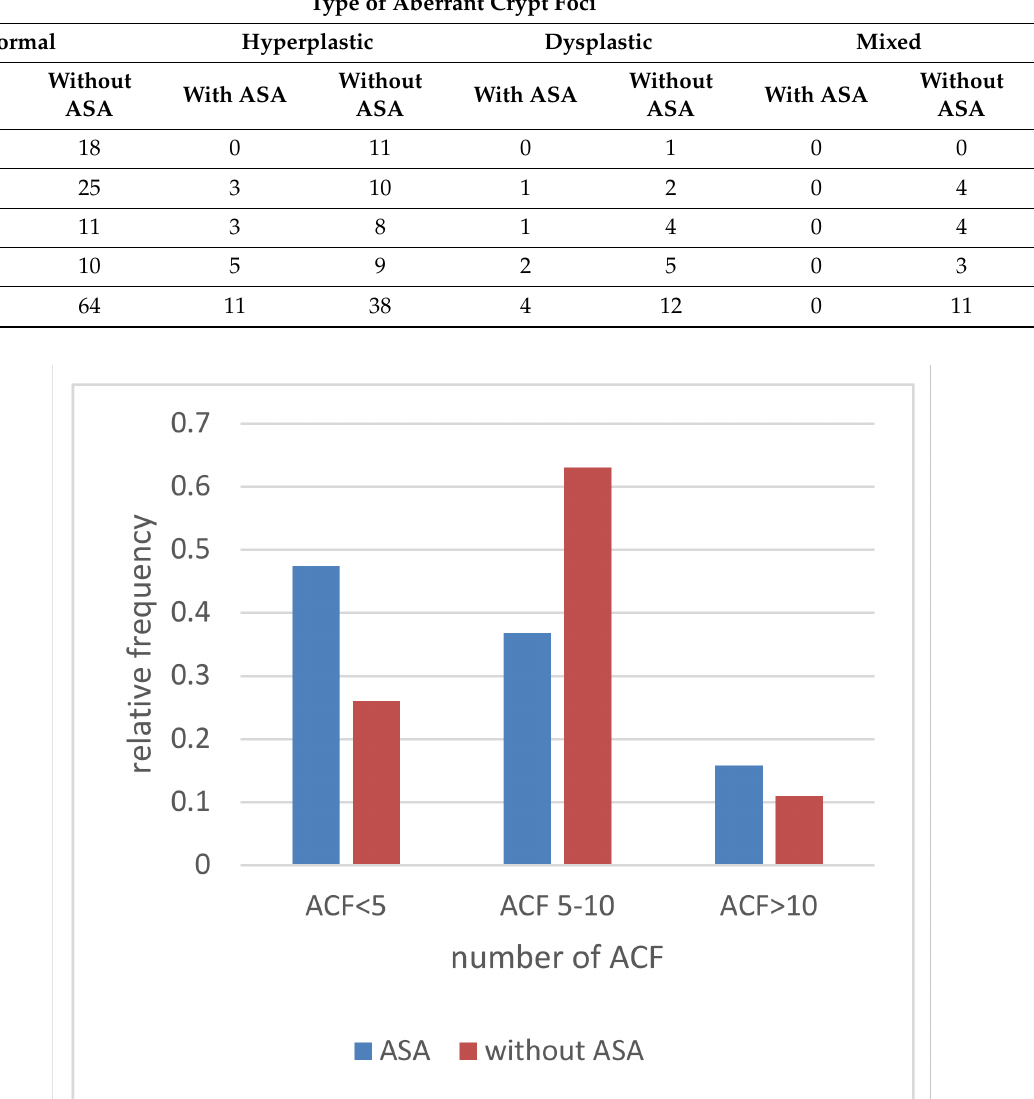
Figure 1. Relationship of the incidence of rectal aberrant crypt foci (ACF) counts to with ASA or without ASA. The rate of ACF formation in patients without ASA is higher than in patients with ASA. There is a difference in the probability distributions of the occurrence of ACF count in patients with and without ASA and it is statistically significant according to the X2 criterion with a significance level of p <